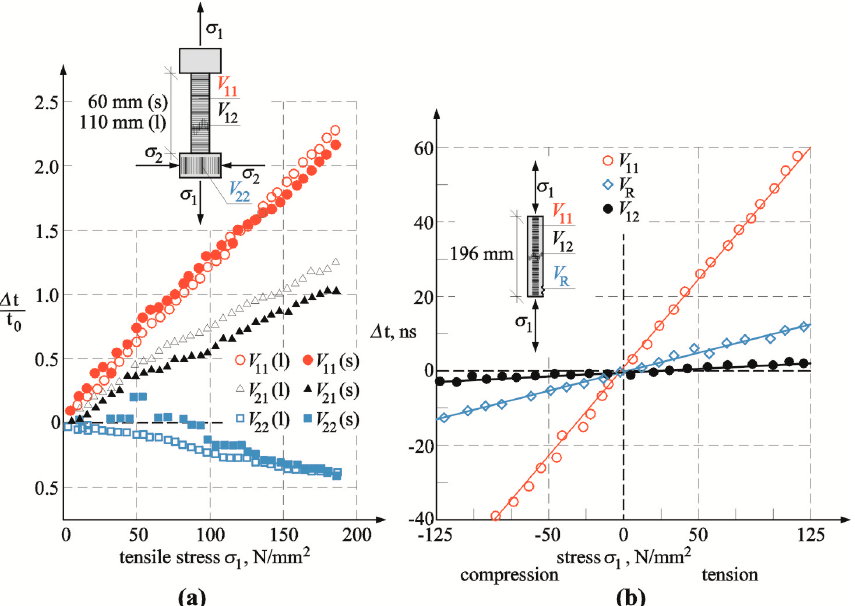
Figure 2. Selected test results for acoustoelastic effect: ( a ) ratio of changes in velocity of waves of different length obtained from tests (adapted from [38]), ( b ) changes in velocity of longitudinal, transverse, and Rayleigh waves obtained from tests (adapted from [40]).